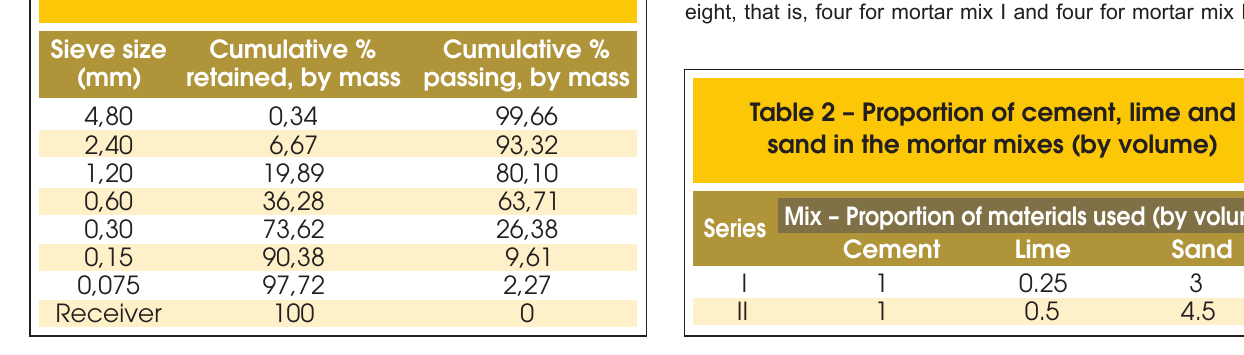
Table 1 – Gradation tests of the